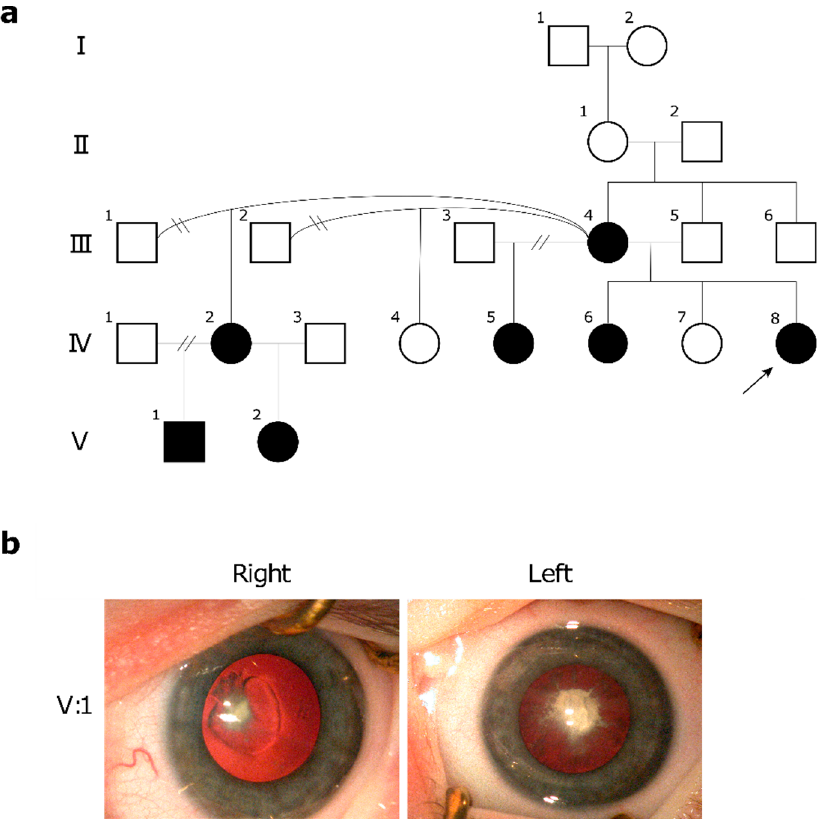
Figure 2. Pedigree and clinical images of family 2 identified as heterozygous for splicing variant EPHA2 c.2826-9G>A. ( a ) Pedigree of family 2 with bilateral microphthalmia and congenital cataract. The proband is indicated with an arrow. Solid symbols indicate affected individuals and blank symbols indicate unaffected individuals. Women are represented by circles. Men are represented by squares. A break in the relationship line indicates the relationship no longer exists. ( b ) Clinical images of irregular nuclear and cortical lens opacities in patient V:1, age five, prior to removal.